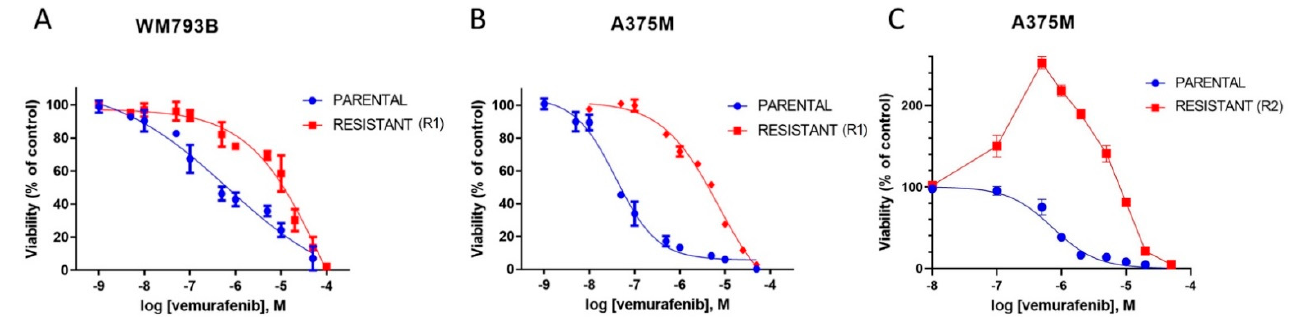
Figure 1. Shift in IC 50 values following acquired resistance to vemurafenib in WM793B and A375M cell lines. WM793B ( A ) and A375M ( B ) parental and resistant cell lines were exposed to serial dilutions of vemurafenib (from 1 nM to 50 µ M) for 72 h and cell viability was assessed by MTT assay. Vemurafenib-resistant melanoma cell lines WM793B-R1 and A375M-R1 showed 33-fold and 224-fold increased resistance to vemurafenib, respectively. Prolonged treatment of A375M cell line with vemurafenib (7 months, R2) resulted in peak viability of resistant cells at the concentration of vemurafenib at which they were grown ( C ). Each curve represents the mean ± SD from three to four independent experiments performed in quadruplets for each vemurafenib concentration.